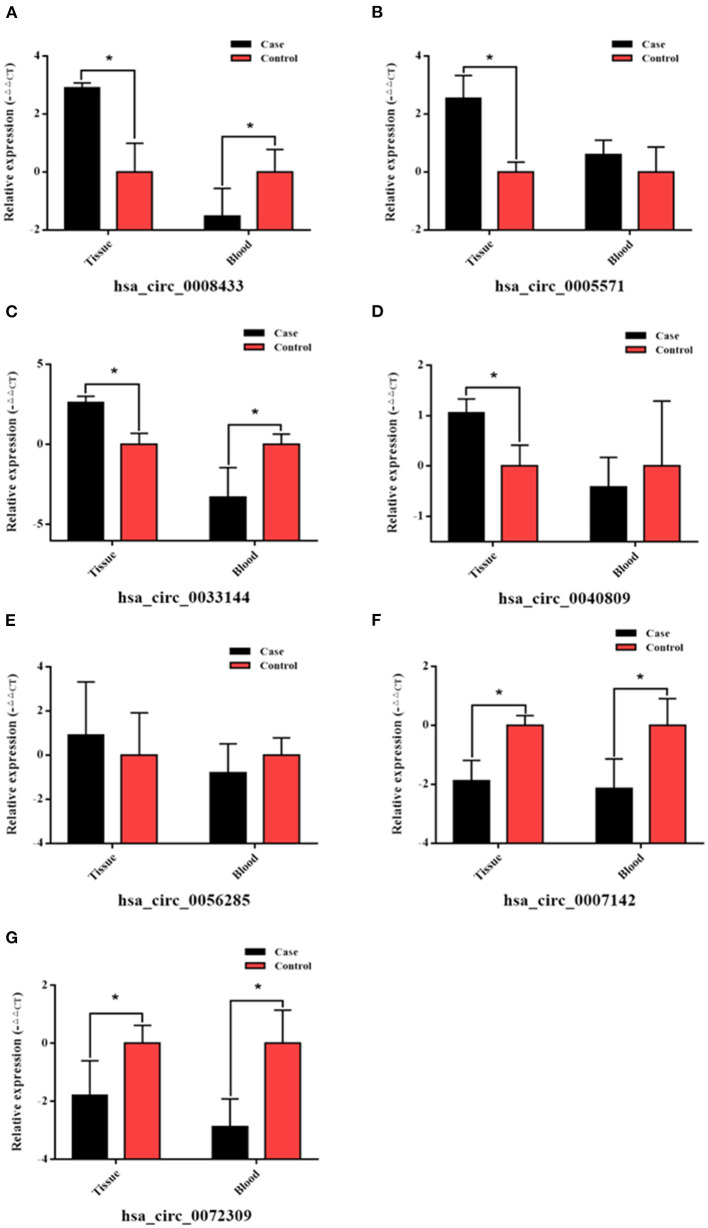
qRT-PCR verification of specific circRNAs in IA tissue and peripheral blood of case and control group. (A–G) The PCR results of the 7 selected circRNAs hsa_circ_ (0008433, 0005571, 0033144, 0040809, 0056285, 0007142, 0072309) in IA tissue and peripheral blood, *P < 0.05.